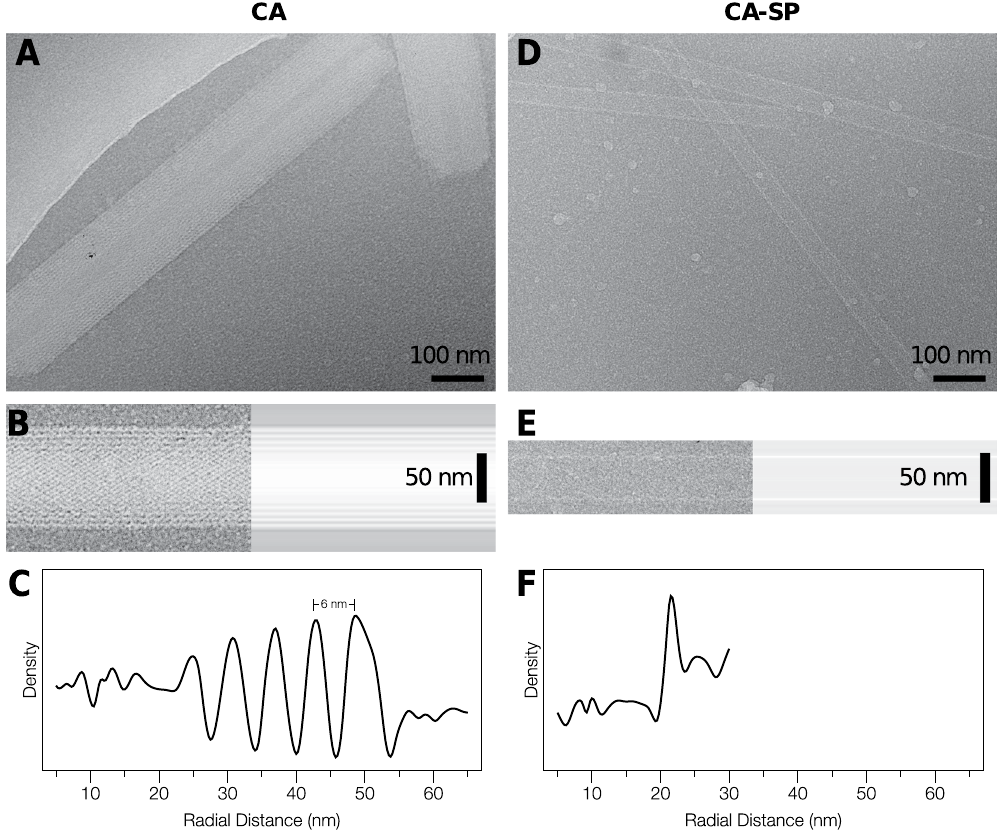
Figure 6. RSV CA and CA-SP Tubes imaged using Cryo-EM. ( A ) and ( D ) Images of tubes suspended in vitreous ice. ( B ) and ( E ) Image of a tube (left), together with the longitudinally-averaged image of the same tube (right). ( C ) and ( F ) Mean radial density profiles for the tubes shown in ( B ) and ( E ) respectively. These were obtained from the longitudinally-averaged projection image via the inverse Abel transform. For this analysis, the images were not corrected for the effects of the contrast transfer